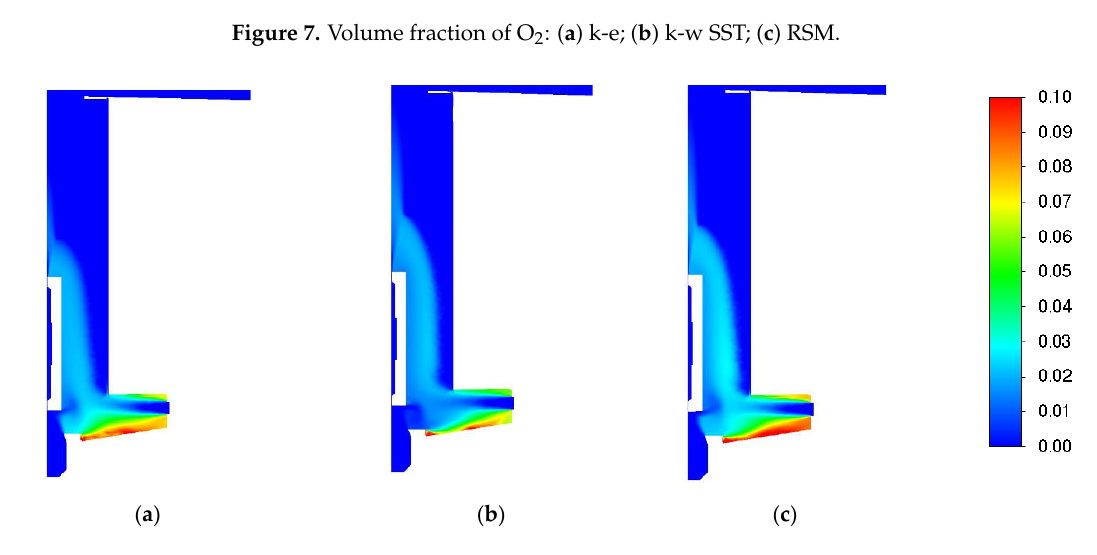
Figure 7. Volume fraction of O 2 : ( a ) k-e; ( b ) k-w SST; ( c ) RSM.